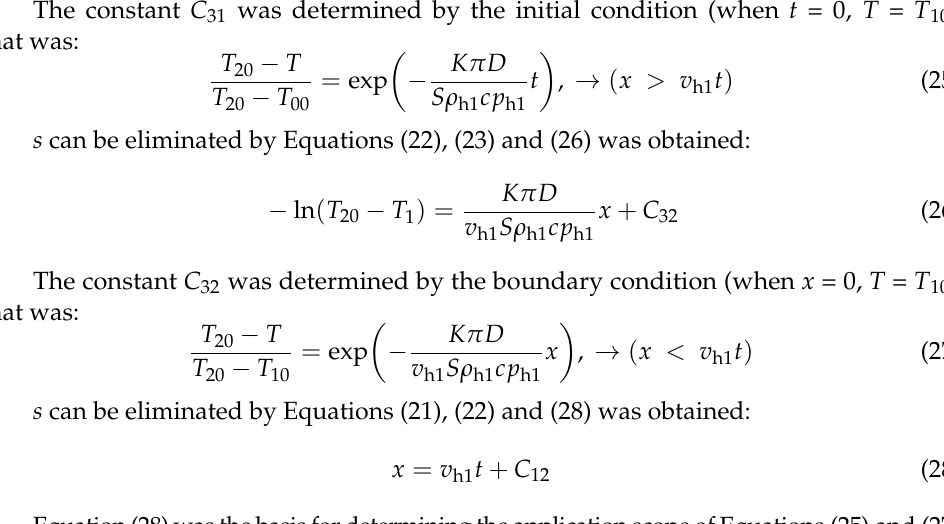
output hot fluid of the previous stage was used as the input hot fluid of the latter stage, and the multi-stage condensers can be simplified and combined. Taking the four-stage condensers as an example, the structure and model are shown in Figure 3.